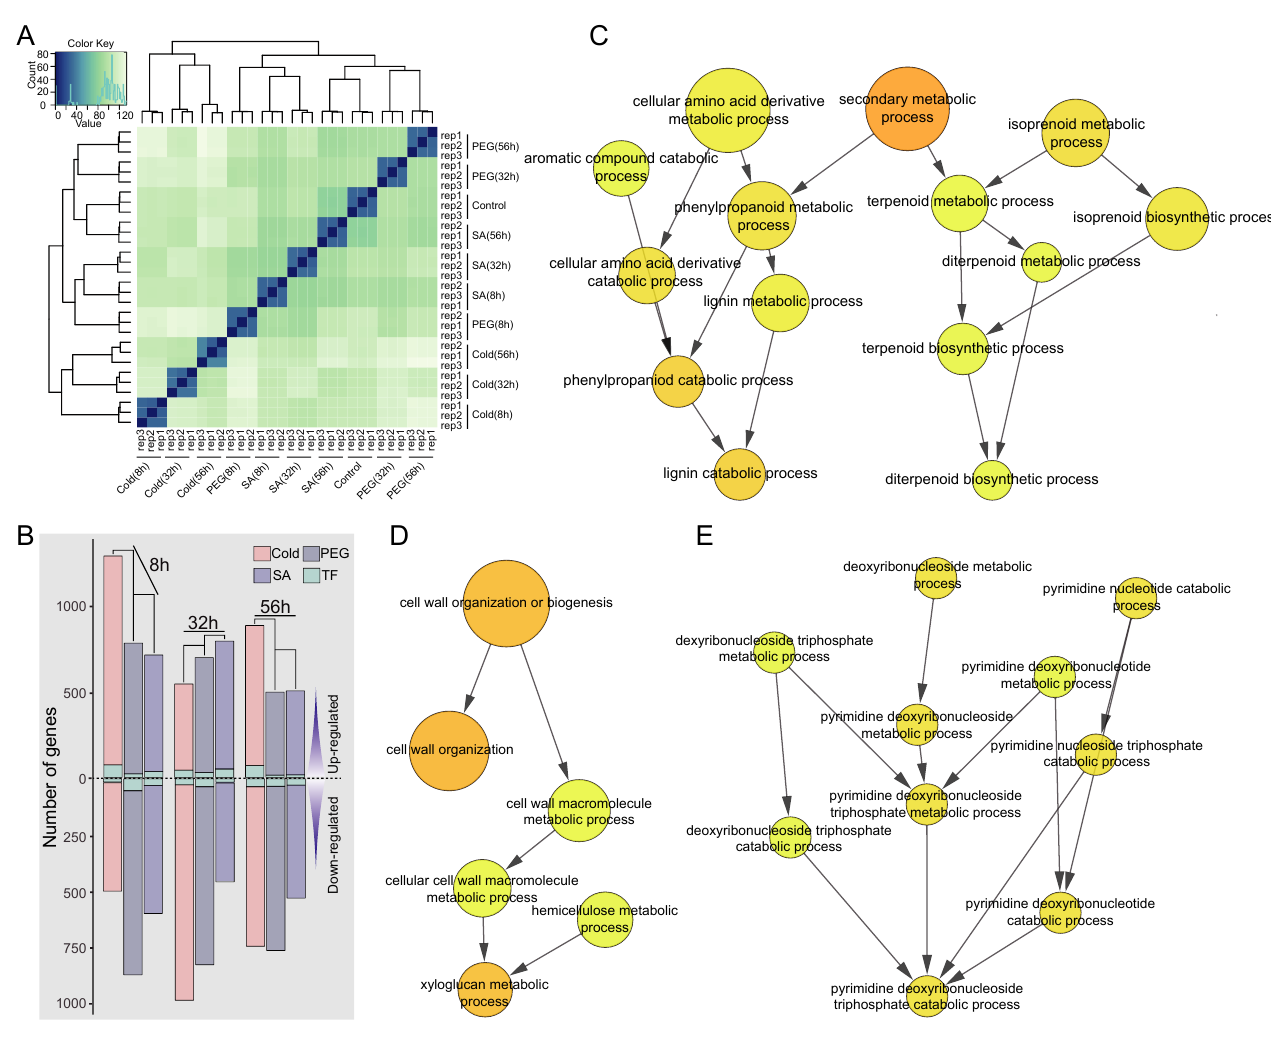
Figure 3. Enrichment analysis of differentially expressed genes and gene ontology under different stress treatments. ( A ) principal component analysis for RNA-Seqs; ( B ) pink, gray, and purple repre- sent differentially expressed genes under cold, PEG, and SA treatments, respectively; blue color rep- resents TFs; ( C ) Differentially expressed genes were enriched in lignin catabolism; ( D ) Differentially expressed genes were enriched in xyloglucan metabolism; ( E ) Differentially expressed genes were enriched pyrimidine